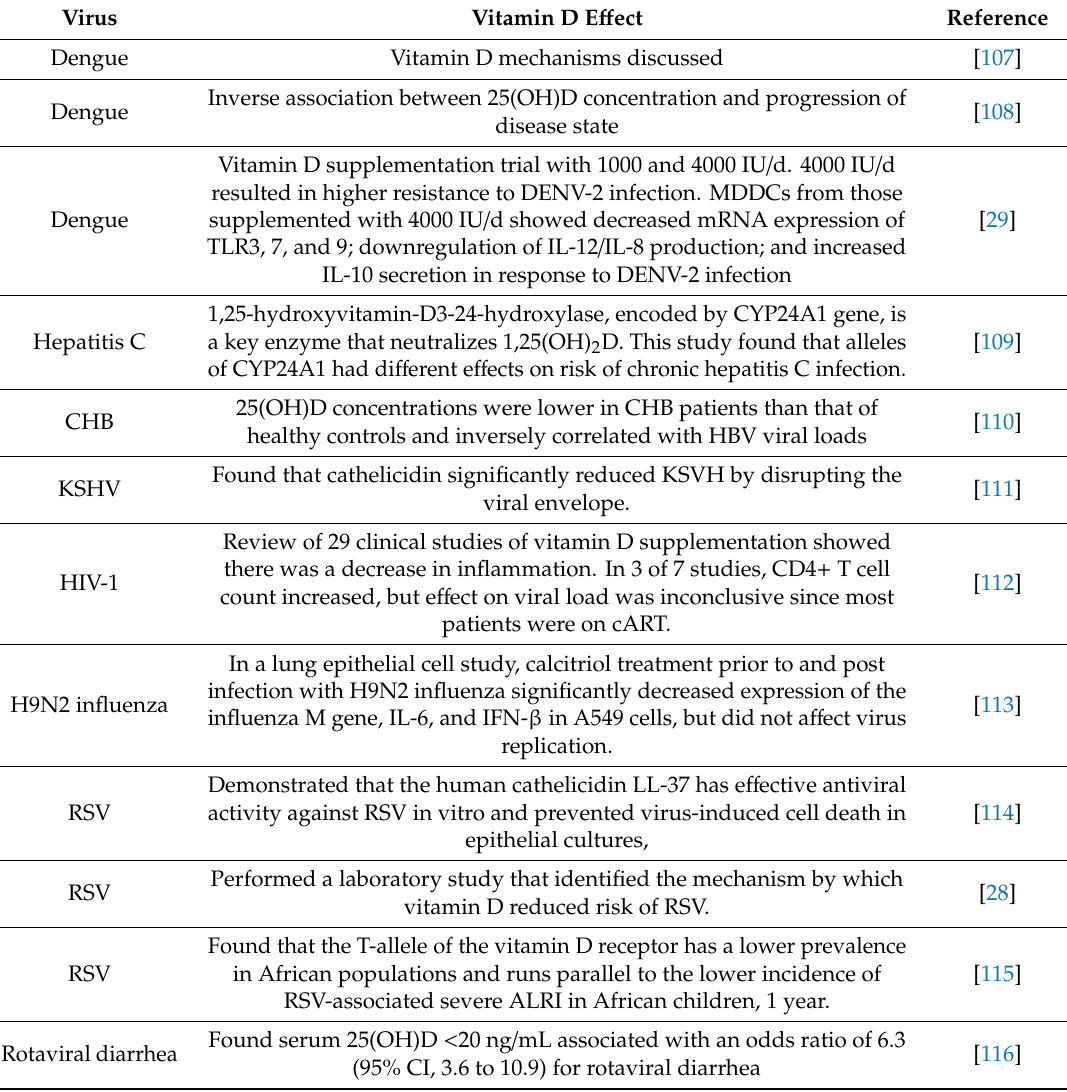
Table 4. Findings regarding the associations and e ff ects of vitamin D on enveloped viral